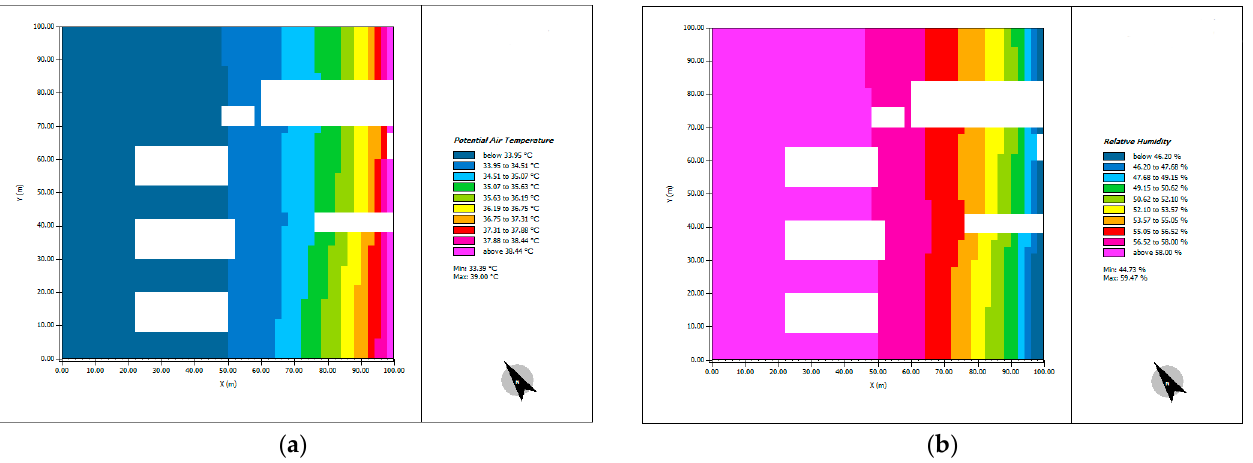
Figure 9. ( a ) ENVI-met simulated T a distribution on 27 July 2020 at 15:00 p.m.; ( b ) ENVI-met simulated RH distribution on 27 July 2020 at 15:00 p.m.